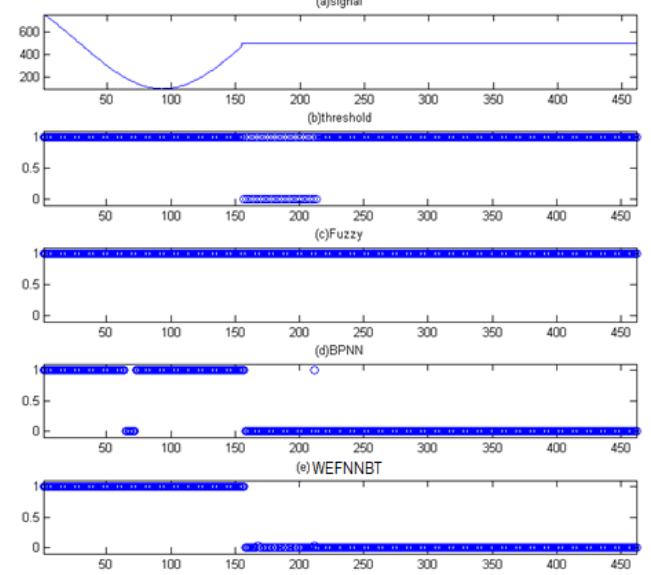
Figure 9. ( a ) Waveform of interruption, ( b ) state of protective relay based on identification with TM for interruption, ( c ) state of protective relay based on identification with FA for interruption, ( d ) state of protective relay based on identification with BPNN for interruption, and ( e ) state of protective relay based on identification with proposed WEFNNBT for interruption.